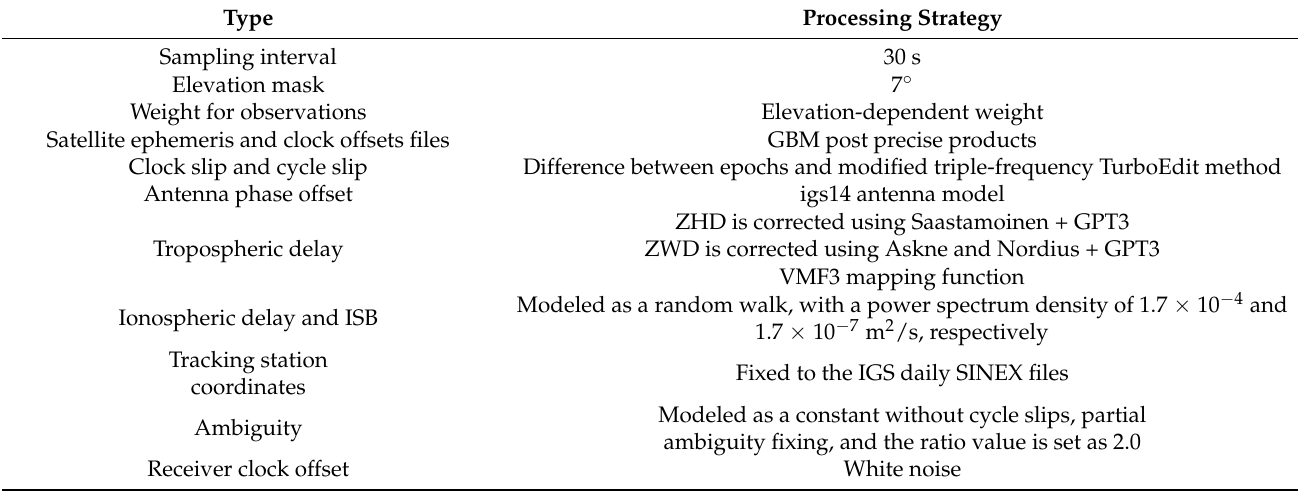
Table 1. Processing strategies of the IFCBs and OSBs estimation, and multi-GNSS and multi- frequency PPP.